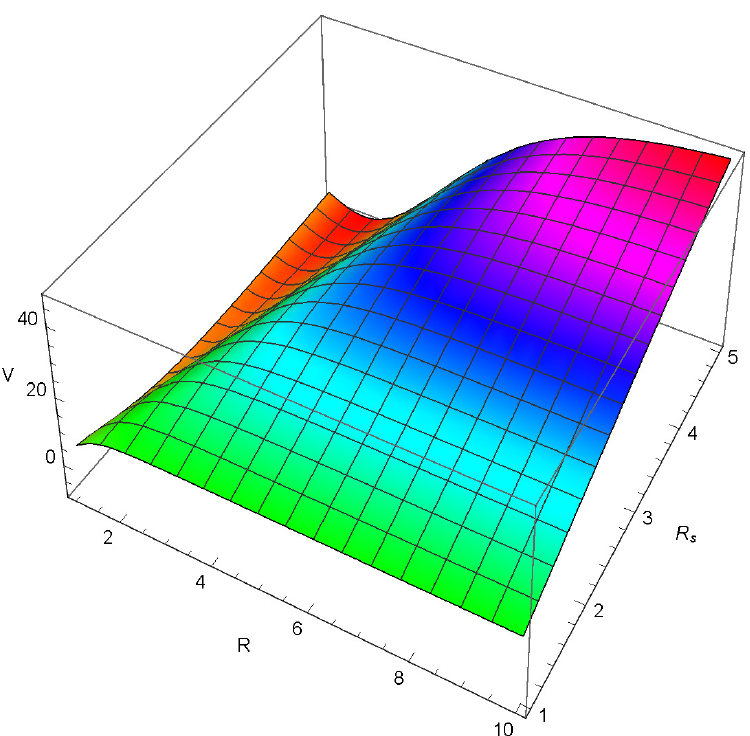
Figure 30. Solution of V ( φ 2 ) for n = 3. The evolution of V ( φ 2 ) is obtained using Equations (32) and (45). The scalar potential converges to zero as the Ricci scalar ( R )